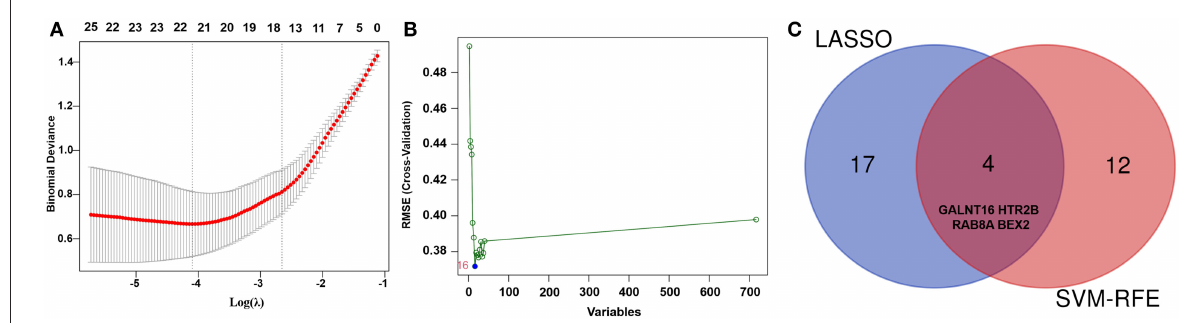
FIGURE4 Identification of key genes of AF by machine learning. (A) The key genes identified by LASSO regression in AF patients. (B) The key genes identified by the SVM-RFE algorithm in AF patients. (C) Representative Venn diagram showing the genes extracted using SVM-RFE and LASSO.